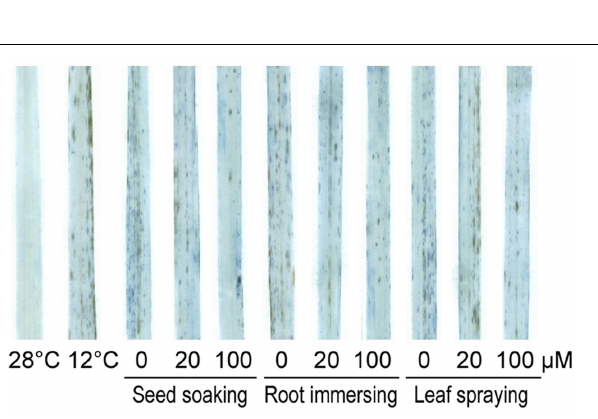
non-photochemical quenching (NPQ) was significantly increased after 6-day cold stress ( Figures 7B,D ). This increase was partly reversed by melatonin application ( Figures 7B,D ). The chlorophyll fluorescence data suggested that the seed soaking and root immersing applications were more effective than the leaf spraying ( Figure 7